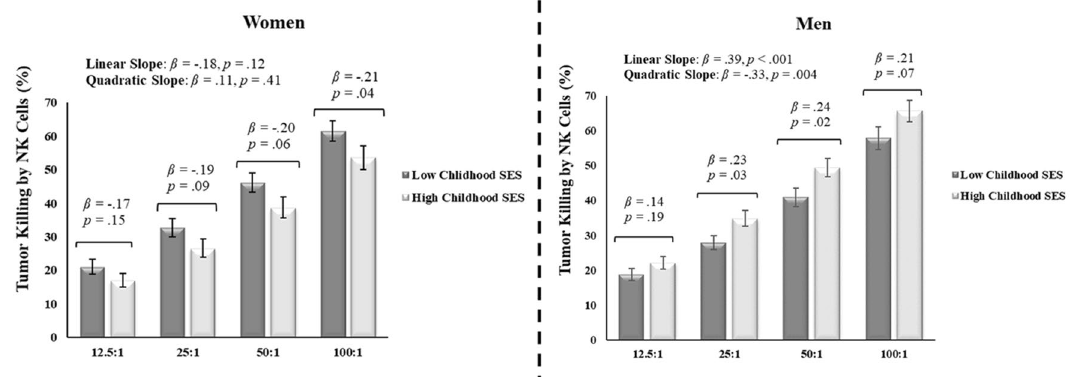
Figure 2. Interaction between childhood socioeconomic status (SES) and sex on natural killer (NK) cell killing of tumor cells (i.e., cytotoxicity) across effector:target cell ratios (12.5:1, 25:1, 50:1, and 100:1). Error bars reflect standard errors. High and low childhood SES refer to one standard deviation above and below the mean of this variable,